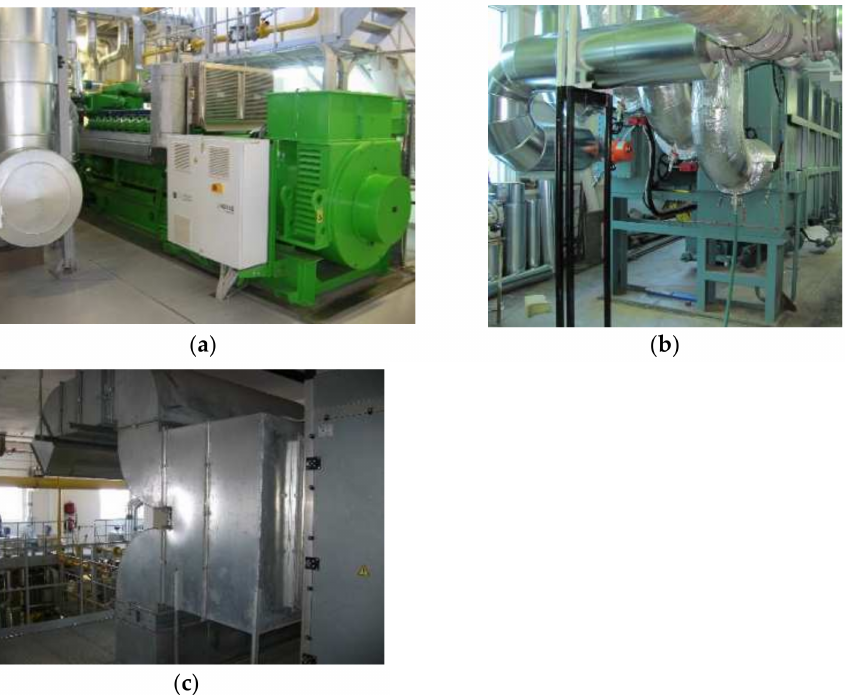
Figure 2. Gas engine module JMS GE Jenbacher ( a ), absorption chiller AR-D500L2 ( b ), and central conditioner for engine room incoming air cooling ( c